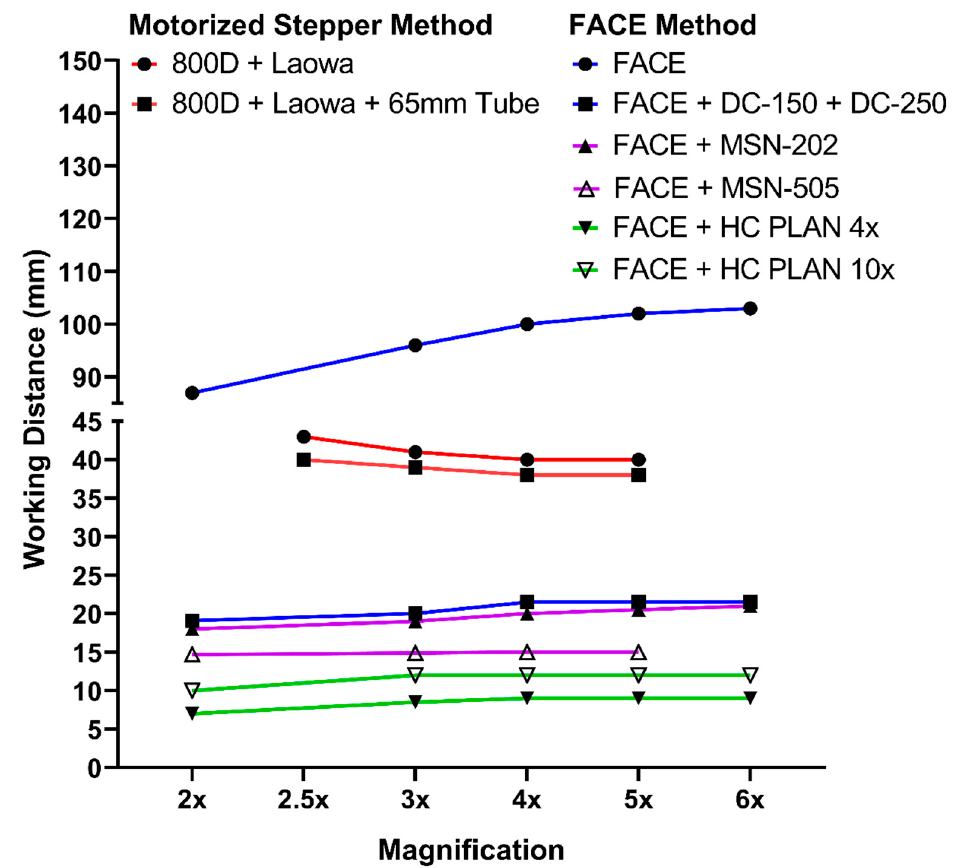
Figure 3. Comparison of the working distance between the current FACE and commercial motorized stepper setups with various lens combinations. The X -axis indicates magnification levels for different photography systems. The Y -axis indicates the corresponding working distance between the lens and objects. Abbreviation: 800D, Canon EOS 800D camera. Laowa, Laowa 25 mm macro lens. Tube, 65 mm extension tubes.